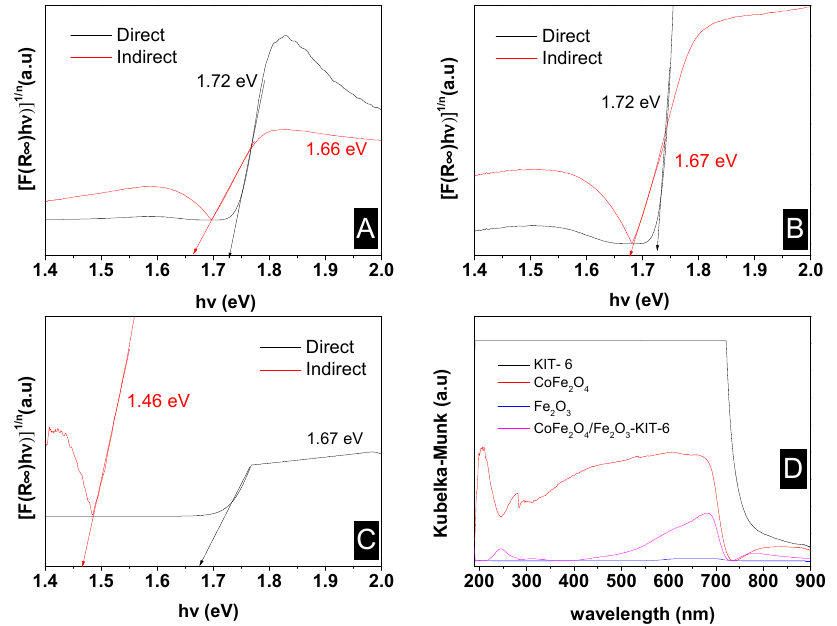
Figure 6. The band gap determination: ( A ) pure cobalt ferrite; ( B ) CoFe 2 O 4 -Fe 2 O 3 -KIT-6 catalyst; ( C ) pure hematite; ( D ) absorption spectrum.